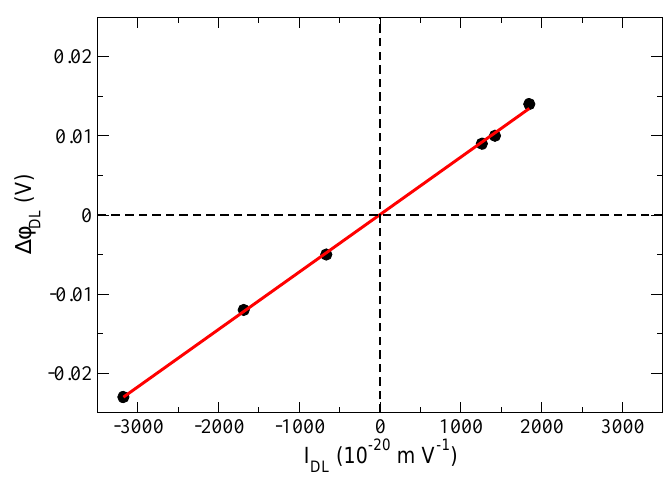
Figure 2. Evolution of the electrostatic potential across the DL ( ∆ φ DL ) as a function of I DL (integral of ( 2 ) ( ω ) in the 3000–3600 cm − 1 region). The black points are the calculated values from the DFT-MD Im χ DL simulations of the various silica–water interfaces for which SFG spectra are plotted in Figure 1; the red line passes through all calculated